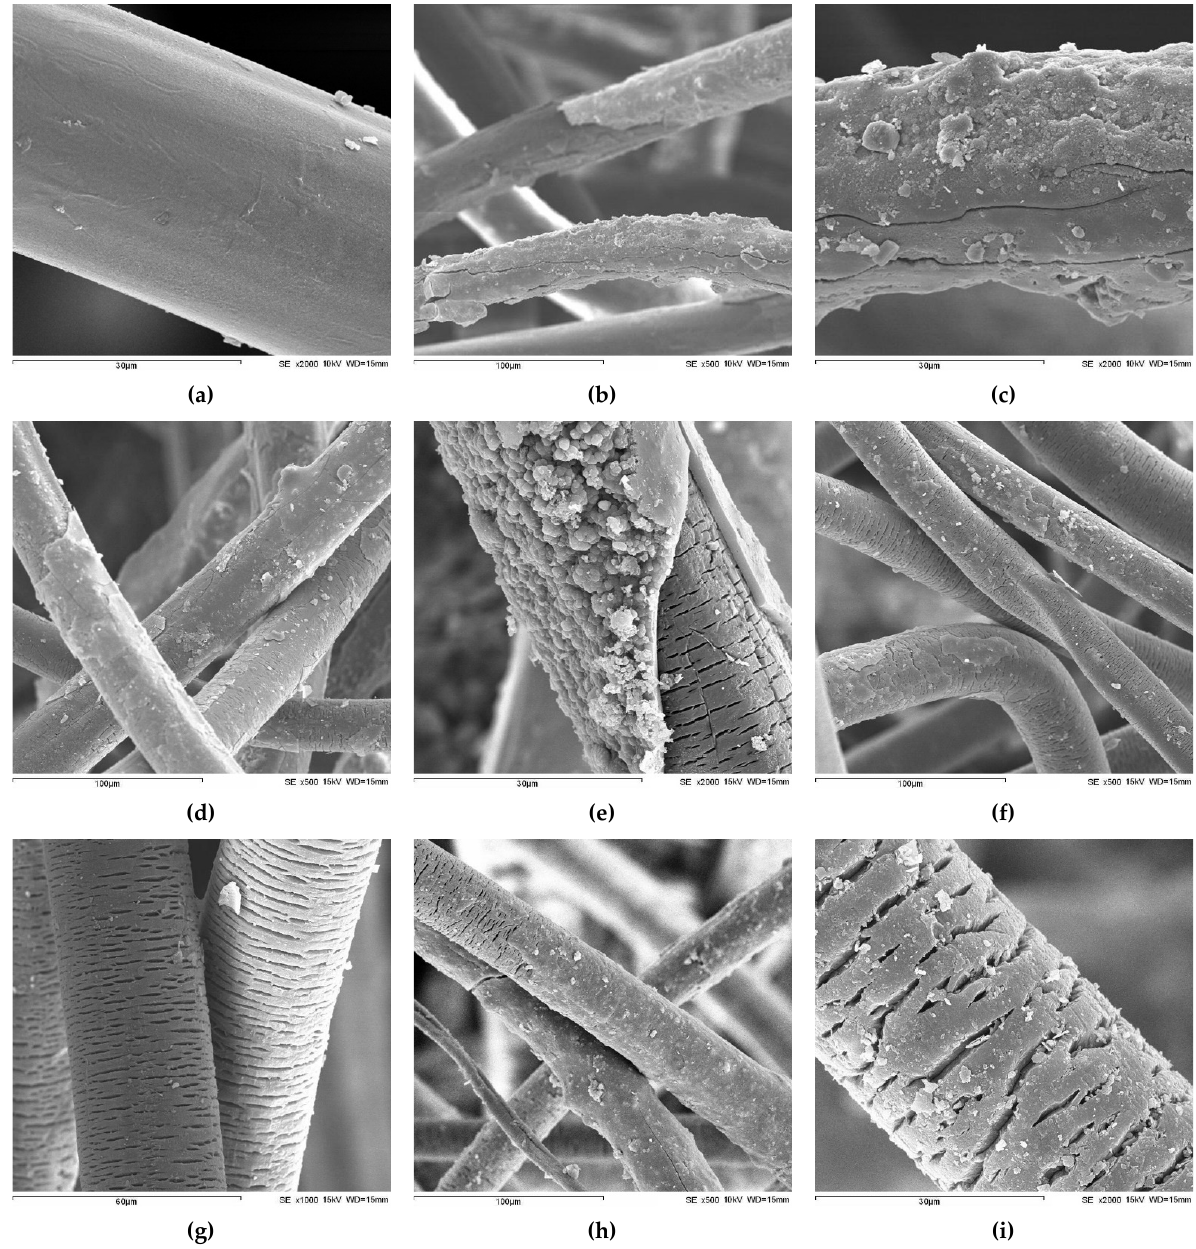
Figure 5. PP fibres of GT500 before and after natural weathering: ( a ) unexposed (2000×); ( b ) 6 months (500×); ( c ) 6 months (2000×); ( d ) 12 months (500×); ( e ) 12 months (2000×); ( f ) 18 months (500×); ( g ) 18 months (1000×); ( h ) 24 months (500×); ( i ) 24 months (2000×). The magnifications correspond to original on-screen values.